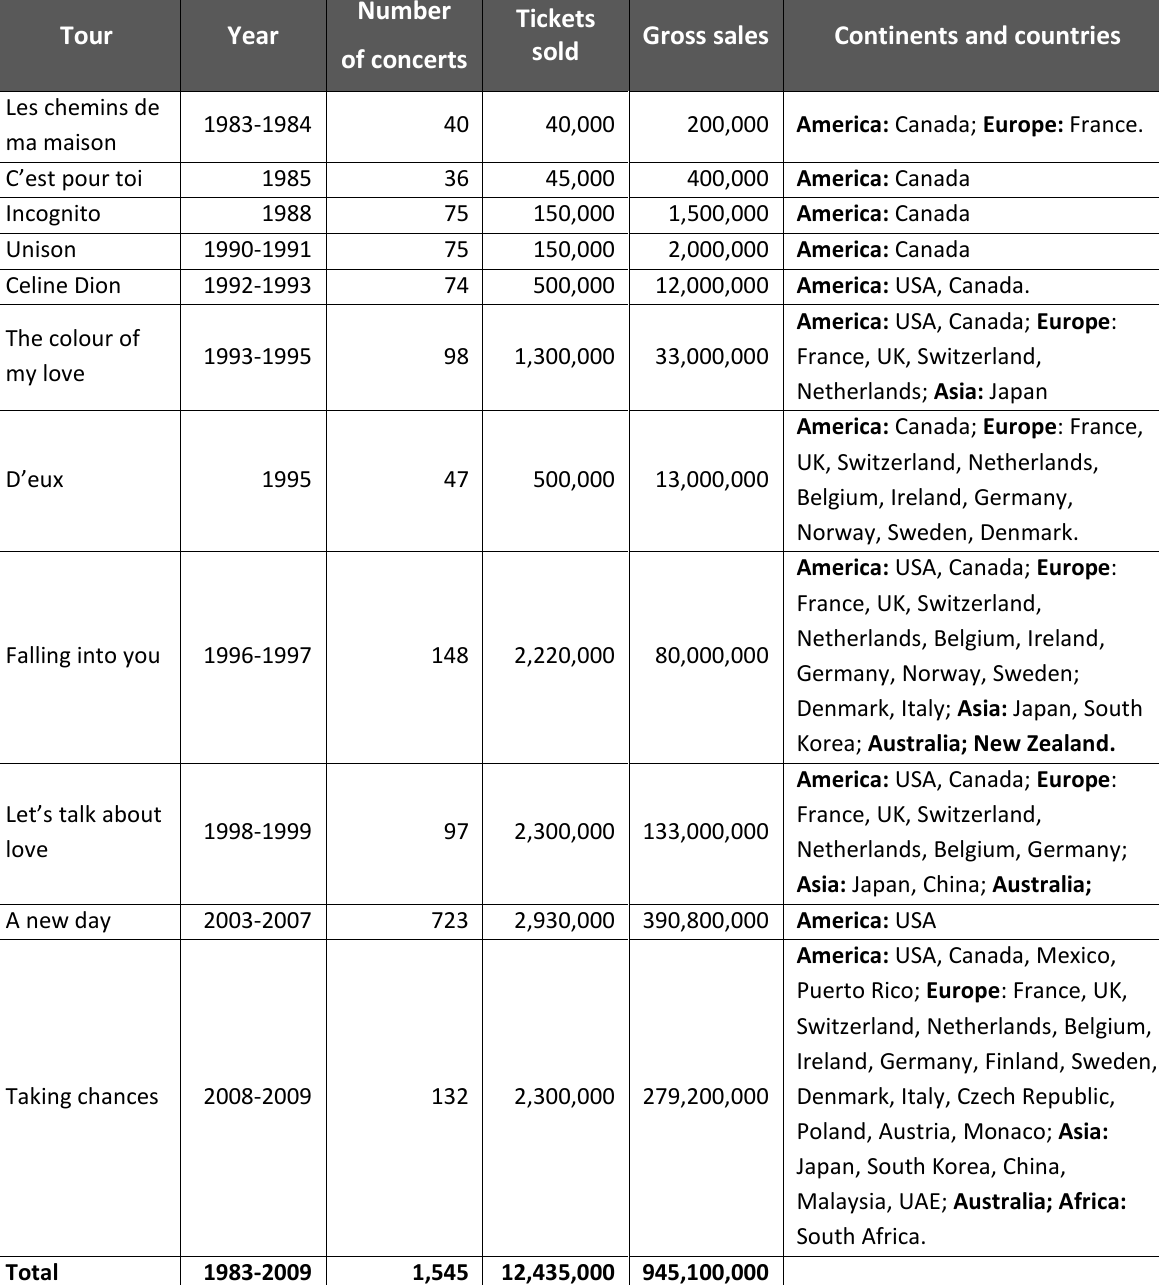
Table 4: Statistical data of most important international worldwide tours and concerts 1983 - 2009